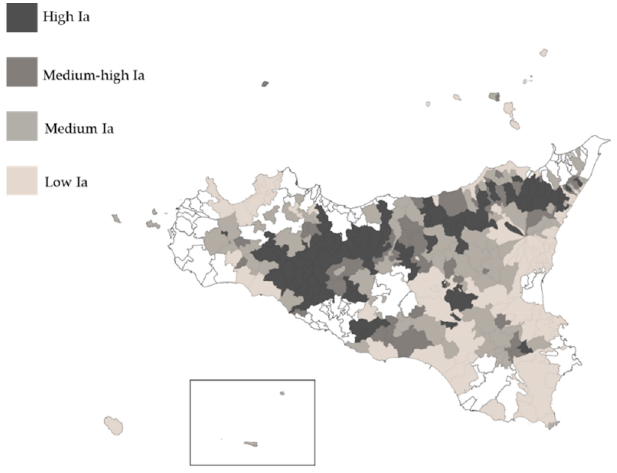
Figure 17. Abandonment map for municipalities in Sicilian metropolitan cities. (Authors’ elabora- tion.)